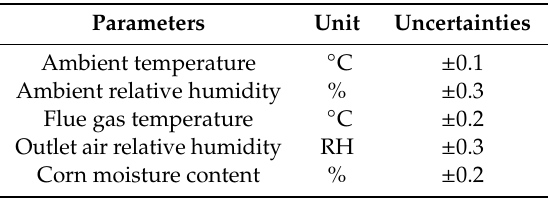
Table 4. Uncertainties of the experimental parameters.